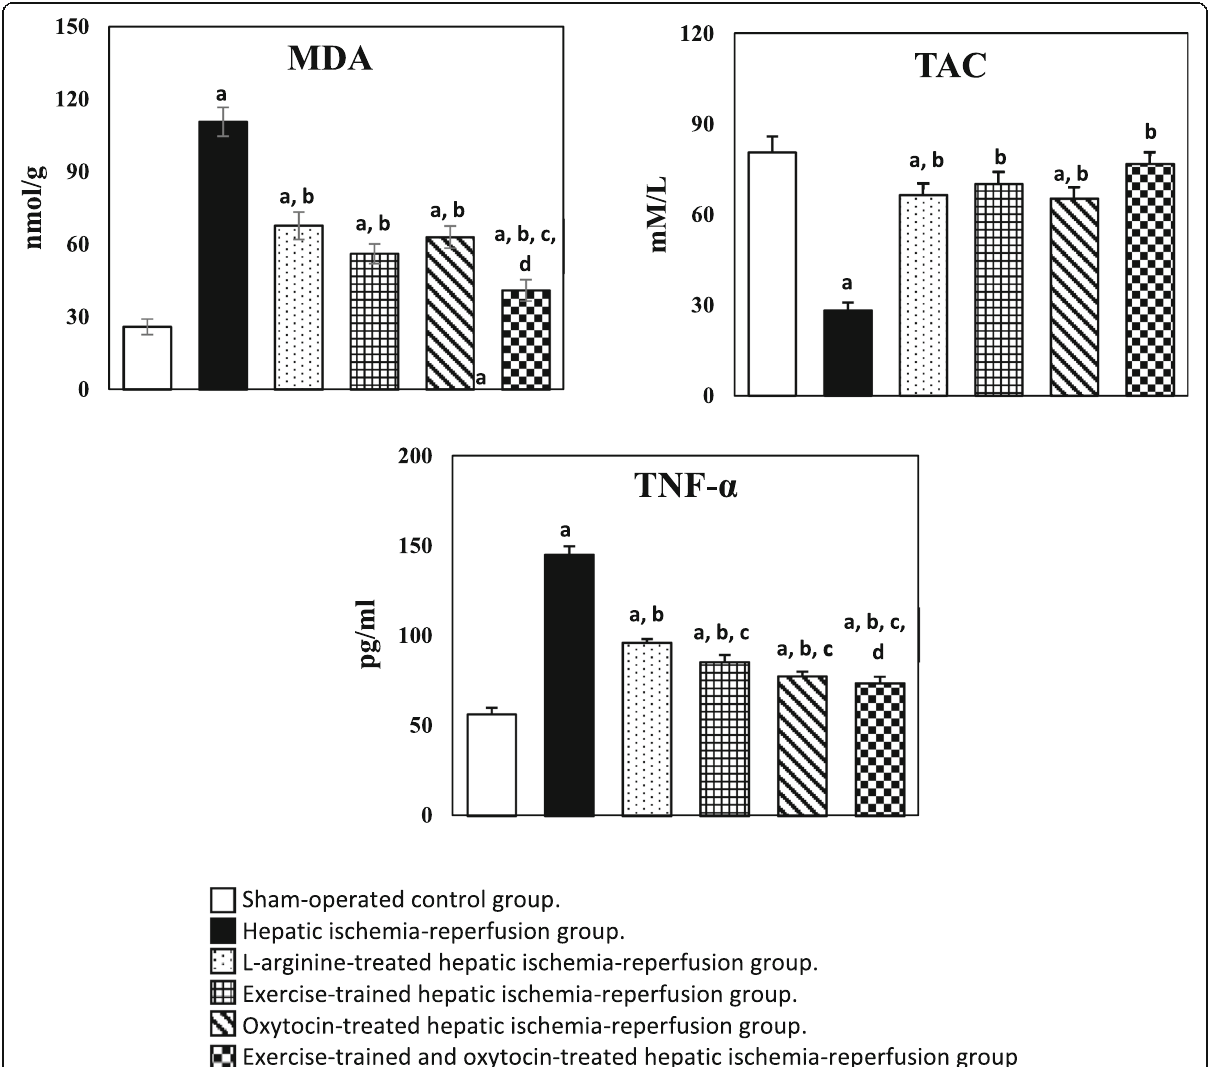
Fig. 2 Plasma levels of malondialdehyde (MDA), total antioxidant capacity (TAC), and tumor necrosis factor-alpha (TNF- α ) in the different studied groups. a Significance from the sham-operated control group calculated by LSD at P <0.05. b The significance from the hepatic ischemia- reperfusion group calculated by LSD at P <0.05. c The significance from the L -arginine-treated hepatic ischemia-reperfusion group calculated by LSD at P <0.05. d The significance from the exercise-trained hepatic ischemia-reperfusion group calculated by LSD at P